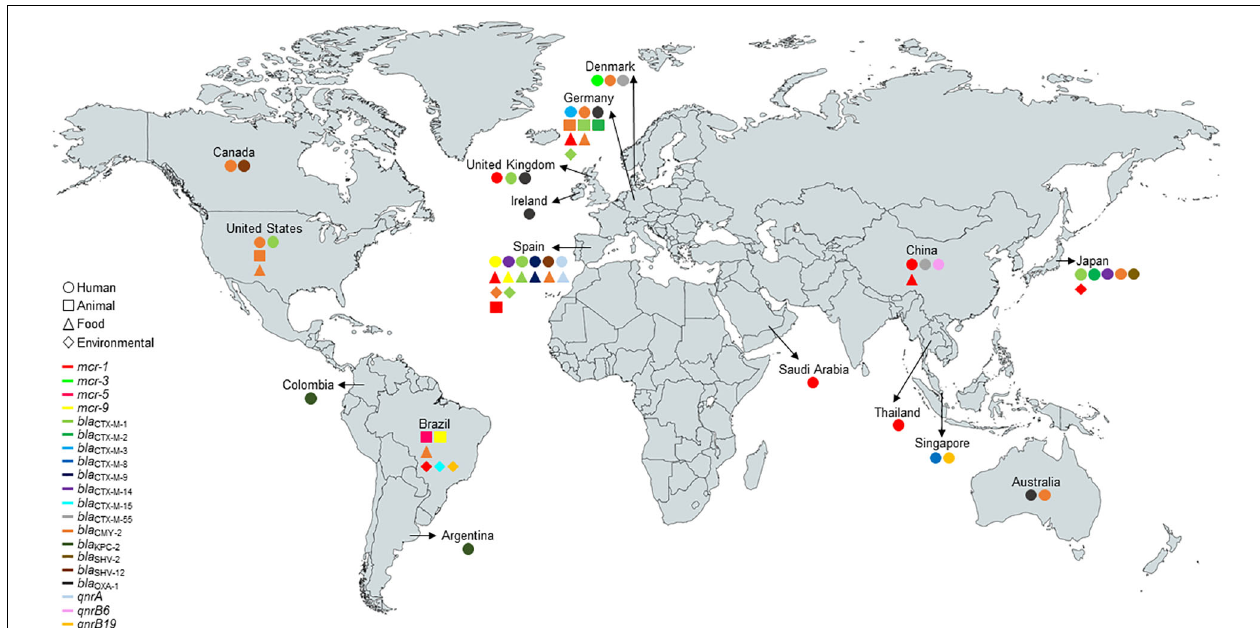
FIGURE 1 | Worldwide distribution and sources of E. coli ST131- H 22 carrying mcr -type, β -lactamase, and qnr -type genes at the human-animal-environment interface. The figure was produced using data retrieved from Enterobase (http://enterobase.warwick.ac.uk/species/index/ecoli) and Pubmed (https://pubmed.ncbi.nlm.nih.gov/) ( bla TEM -types were not included in the figure).